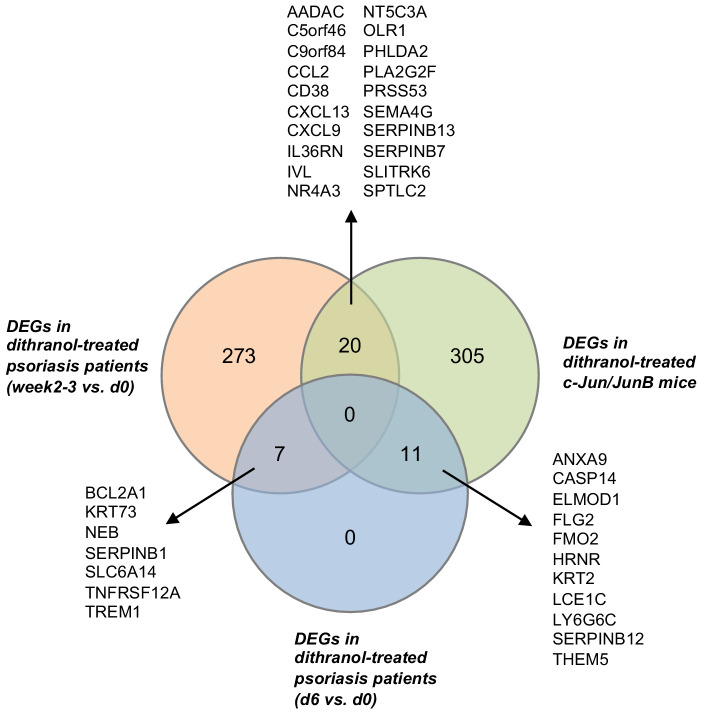
Venn diagram (created using InteractiVenn Heberle et al., 2015) showing comparison and overlap between differentially expressed genes (DEGs) in dithranol-treated human psoriatic skin at week 2–3 vs. day 0, DEGs in dithranol-treated human psoriatic skin at day 6 vs. day 0 and DEGs in dithranol-treated c-Jun/JunB psoriatic skin.